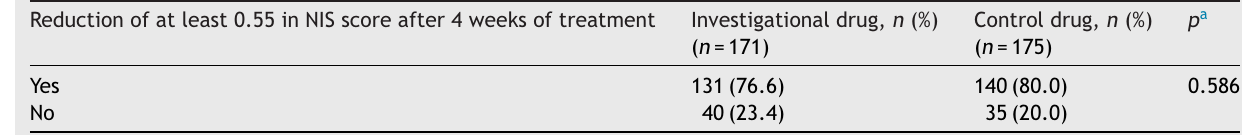
PP, per-protocol population; NIS, nasal index score. a Mann---Whitney